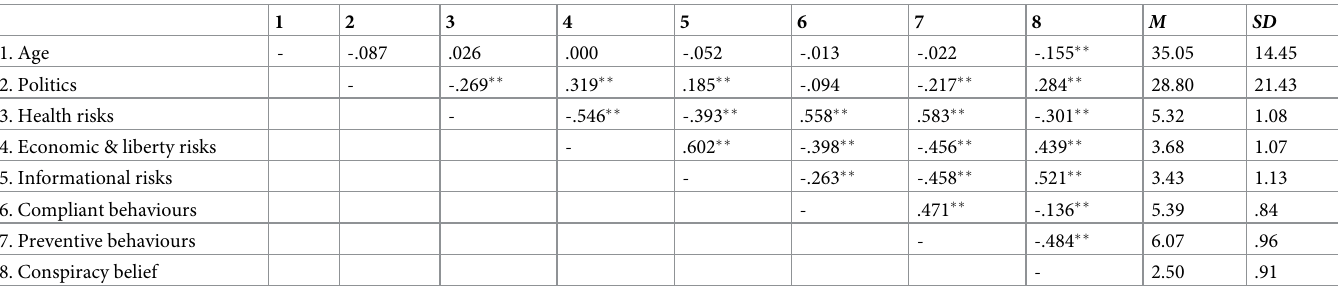
Table 2. Correlation